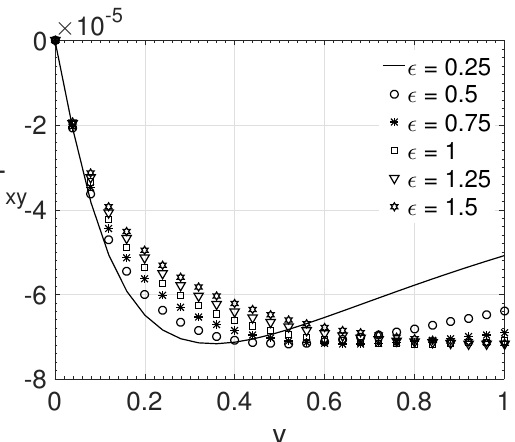
Figure 11. (cid:101) influence on the wall-normal variation y of the extra-stress tensor component T xy . Dimensionless parameters: Re = 1000, β = 0.5, ξ = 0.1 and Wi = 8.